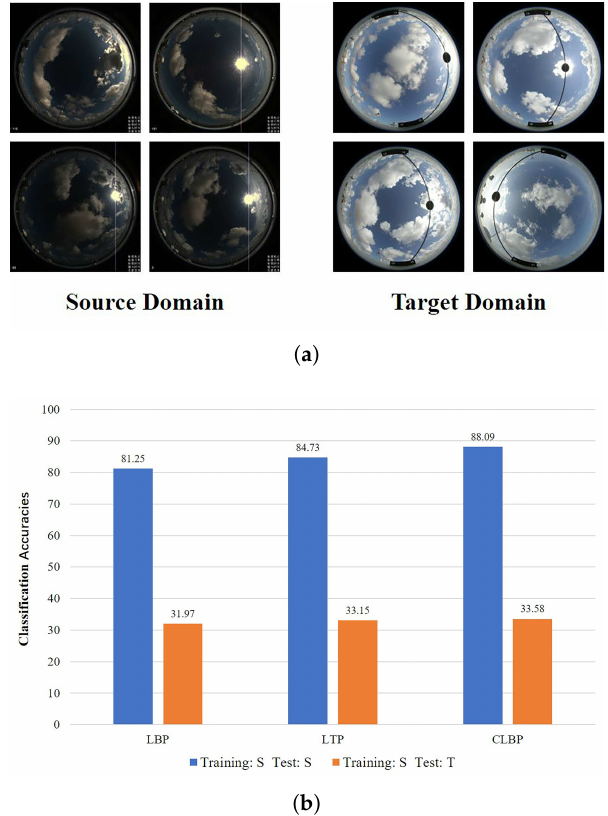
Figure 1. ( a ) Cloud examples from two different domains. In the source domain, the lower right image: the sun seems to be on the right, while in the target domain image, the sun seems to be on the left; ( b ) When these samples are trained in the source domain (S) and tested in the target domain (T), the classification accuracies of three representative methods, i.e., LBP, LTP and CLBP, decrease